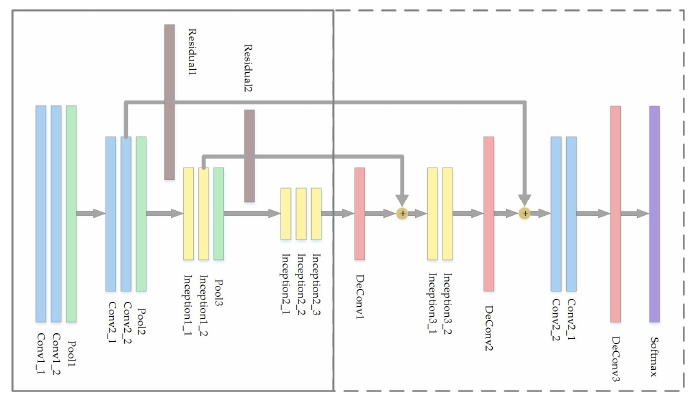
Figure A3. Architecture of HSN, where structure depicted in the solid-line box is encoder and structure depicted in the dashed-line box is decoder.